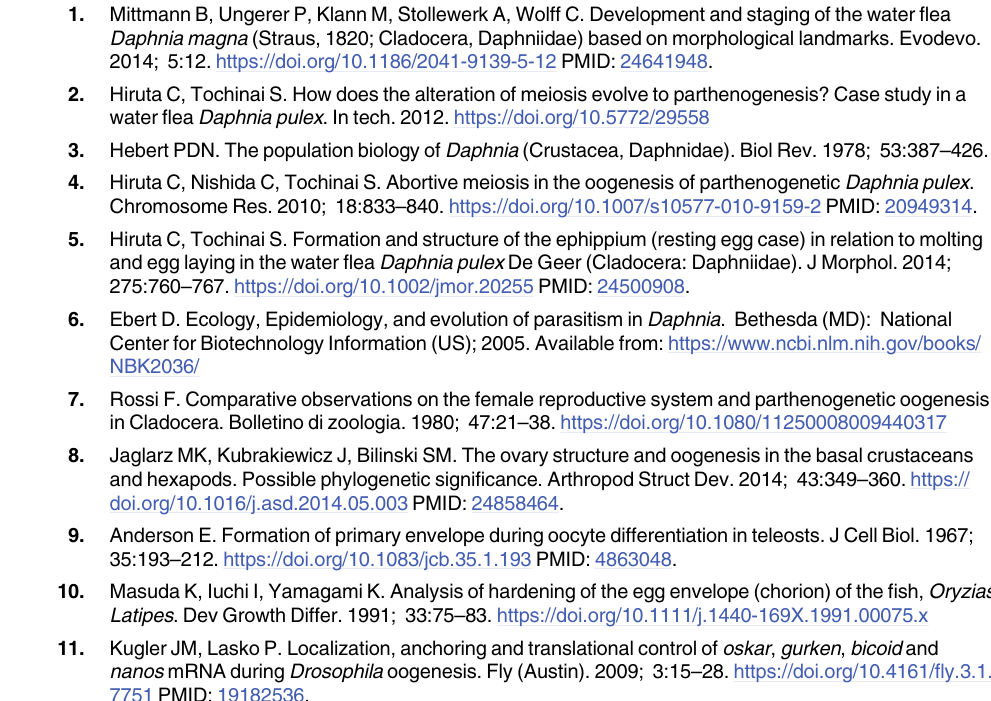
S3 Movie. Live observation of resting egg oviposition by stereo-microscope. The oviposition process of a resting egg in Daphnia magna was recorded using a stereo-microscope. The tim- ing indicated in Fig 3A is matched with the timeline of this movie. S4 Movie. Snapshots of resting egg oviposition by light microscope. The oviposition process of a resting egg in Daphnia magna was recorded using a light microscope. The timing indi- cated in Fig 3B is matched with the timeline of this